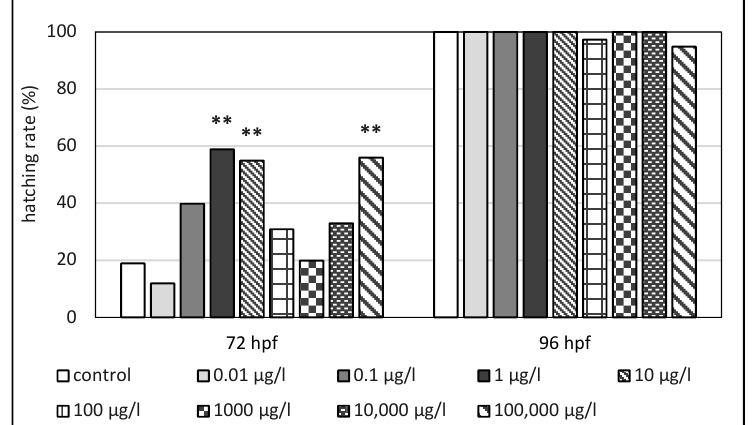
Figure 1. The hatching rate (%) of zebrafish exposed to fluoxetine hydrochloride (hpf—hours post- fertilization). The asterisk indicates a significant difference (** p < 0.01) between the control and the experimental groups at the same time of exposure.